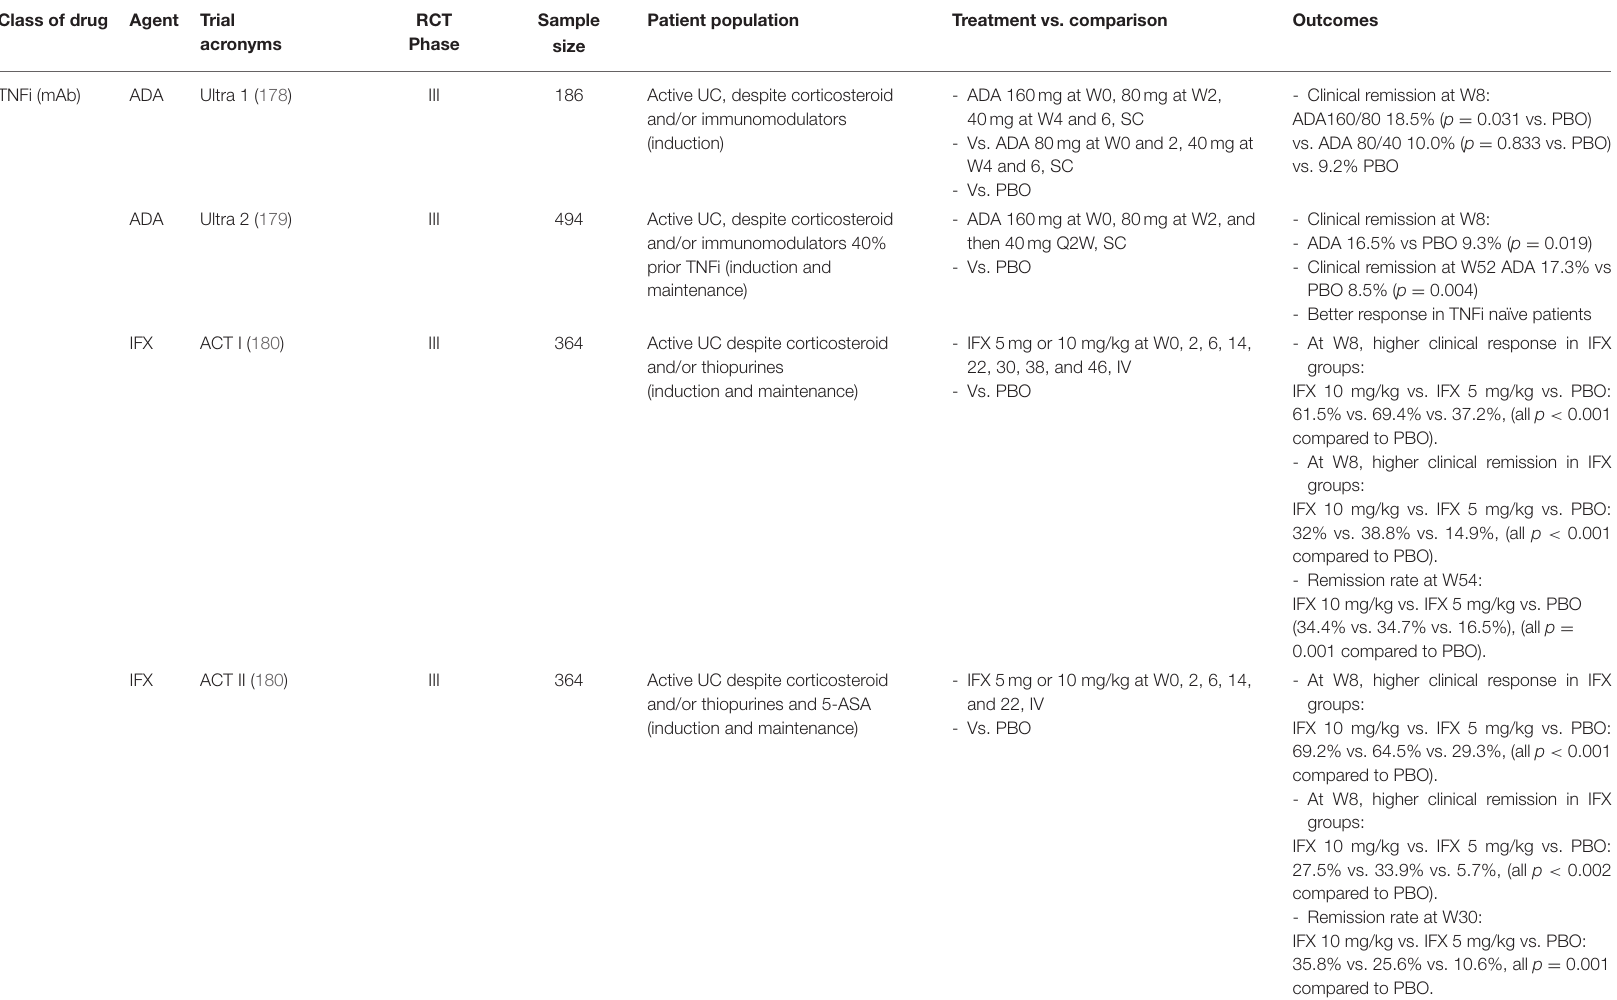
TABLE 3 | Evidence from clinical trials for class of therapeutic options for ulcerative